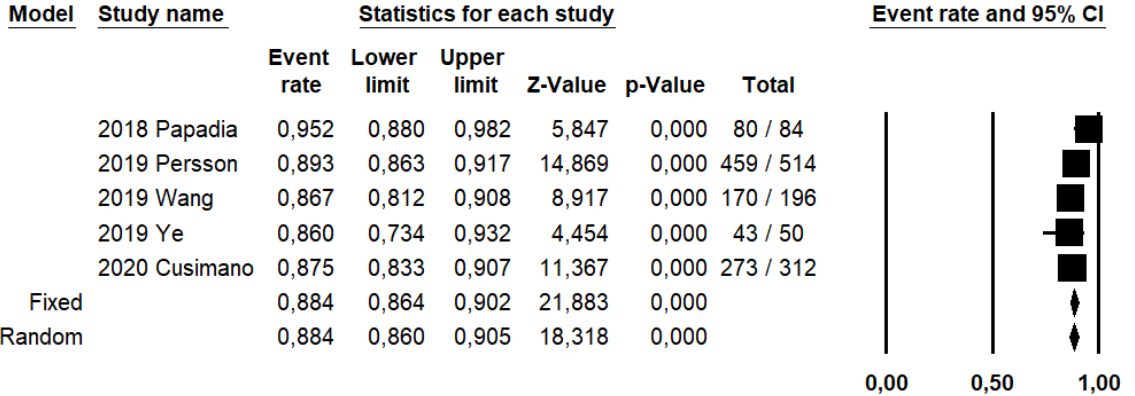
Figure 3. Forest plots of individual studies and pooled detection rate of sentinel lymph node per hemipelvis.